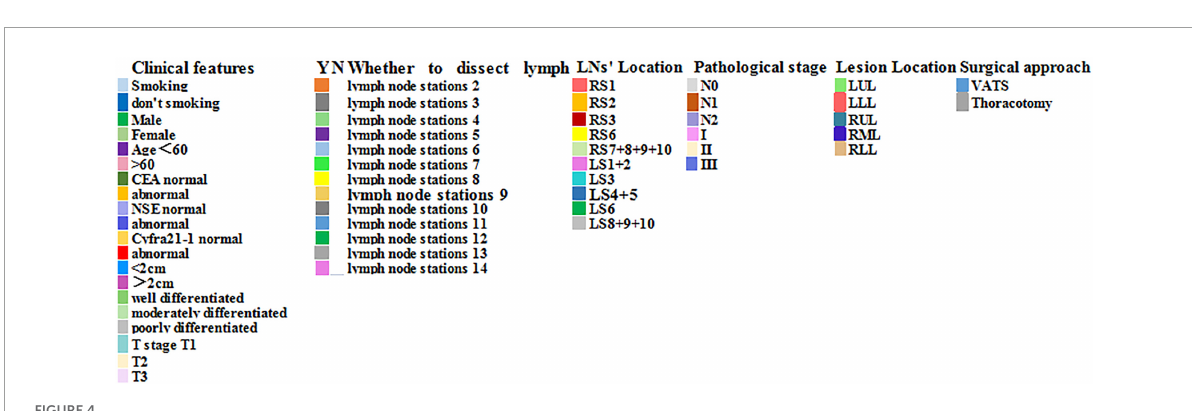
FIGURE4 Meaning of different